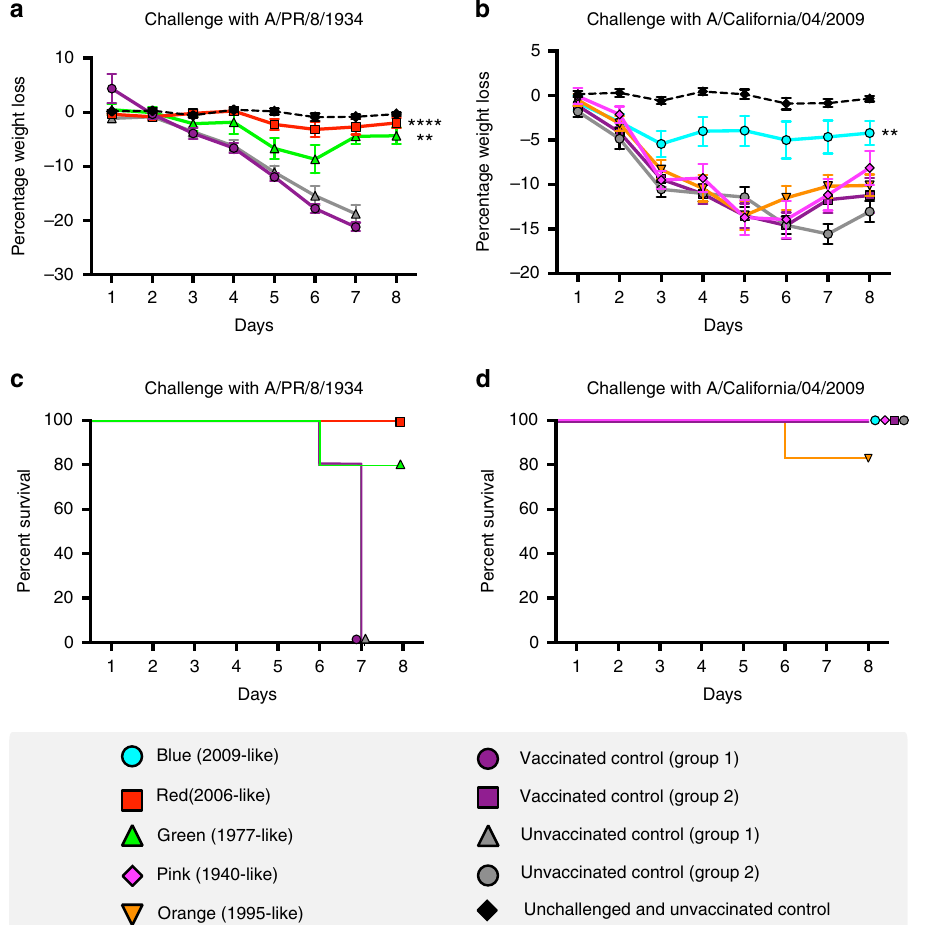
Fig. 5 In fl uenza challenge of vaccinated mice. Mice were challenged with either A/PR/8/1934 ( a , c ) or A/California/4/2009 ( b , d ). a , b The graphs denote daily weight loss of the mice during the challenge. Mice of the same age, which were not vaccinated or challenged, are shown for reference and denoted unchallenged and unvaccinated. c , d Survival curves denoting the number of mice in each group. Mice were euthanised at 20% weight loss. Area under the curve was calculated for the mouse weight loss data and analysed in a single-factor ANOVA. Between-group comparisons were then performed using Tukey ’ s post hoc method for pairwise comparison correction to provide corrected p -values. **** p -value < 0.0001 and ** p -value < 0.010. Error bars are mean ± s.e.m. n = 6 for experimental groups and control Further two groups were mock vaccinated and used as an unvaccinated control. The C179 antibody used as a control in Fig. 1 b – f was obtained from Takara The prime and fi rst boost were administered as a 100-µg intramuscular injection of Bioscience (Product code: SD3145) DNA into the musculus tibialis, whilst the fi nal vaccination was administered as an intramuscular injection into the musculus tibialis of eight HI units of lentivirus Structural bioinformatic analysis . Amino acids present on the surface of various pseudotype displaying the chimeric H11 HA in Alum adjuvant Alhydrogel H1 HAs were determined by calculating the accessibility of amino acids on the (Invitrogen, USA) at a 1:1 volume ratio. surface of the crystal structures of A/Brevig Mission/1/1918 (1RUZ 26 [https://www. Individuals carrying out the mouse vaccination experiments were blinded rcsb.org/structure/1ruz]), A/Puerto Rico/8/1934 (1RU7 26 [https://www.rcsb.org/ regarding the vaccines being administered to the mice; vaccines and cages were structure/1ru7]), A/California/4/2009 (3LZG 28 [https://www.rcsb.org/structure/ numbered and administered as outlined above. The individuals carrying out the 3lzg]) and A/Washington/5/2011 (4LXV 29 [https://www.rcsb.org/structure/4LXV]) experiments were only noti fi ed of the vaccine identities after completion of the HAs using Swiss-Pdb viewer. Areas of 600, 800 and 1000 Å 2 were mapped onto the surface of the crystal structures by determining the distances between the α carbon of a given amino acid and all others within a structure. Those residues whose α carbon sequences were within the speci fi ed area were recorded and used to produce disrupted peptide sequences for a given binding site. ABS variability was calculated as the mean pairwise hamming distance between the consensus sequences collected between 1918 and 2016. The sequences were aligned using MUSCLE before being manually curated using AliView. Vaccination of mice . Animal studies were approved by the University of Oxford Ethical Review Committee and were performed in strict accordance with the terms of a licence granted by the UK Home Of fi ce under the Animal (Scienti fi c Proce- dures) Act 1986 (licence number: 30/2889). Female BALB/c mice, n = 6, (bought from Envigo, UK) were sequentially vaccinated with the OREO sequences substituted into H6, H5 and H11 HA backbones in a prime – boost – boost regime at intervals of 3 – 4 weeks. As a backbone control, two groups were vaccinated with native H6, H5 and H11 constructs.